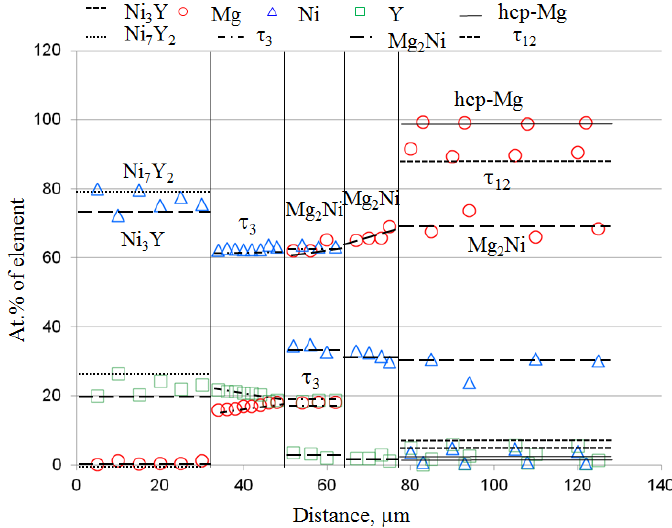
Figure 11. Composition profile of the solid-liquid diffusion couple-1 along the line scan shown in Figure